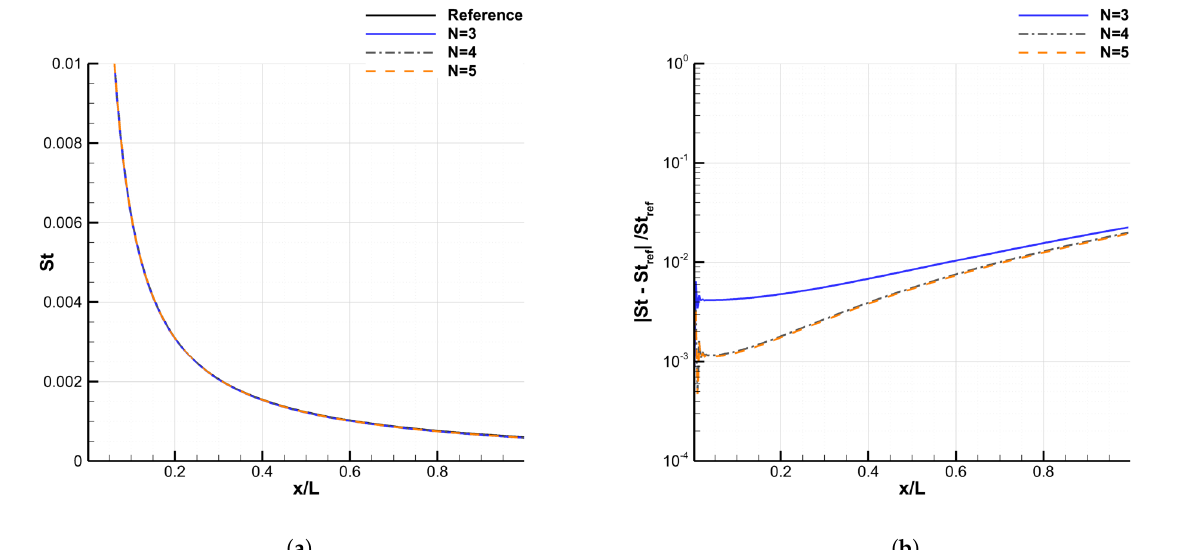
Figure 13. ( a ) Stanton number for N = 3 to N = 5 and ( b ) relative error in the Stanton number. Test case 3, m = 1. N x = 256.